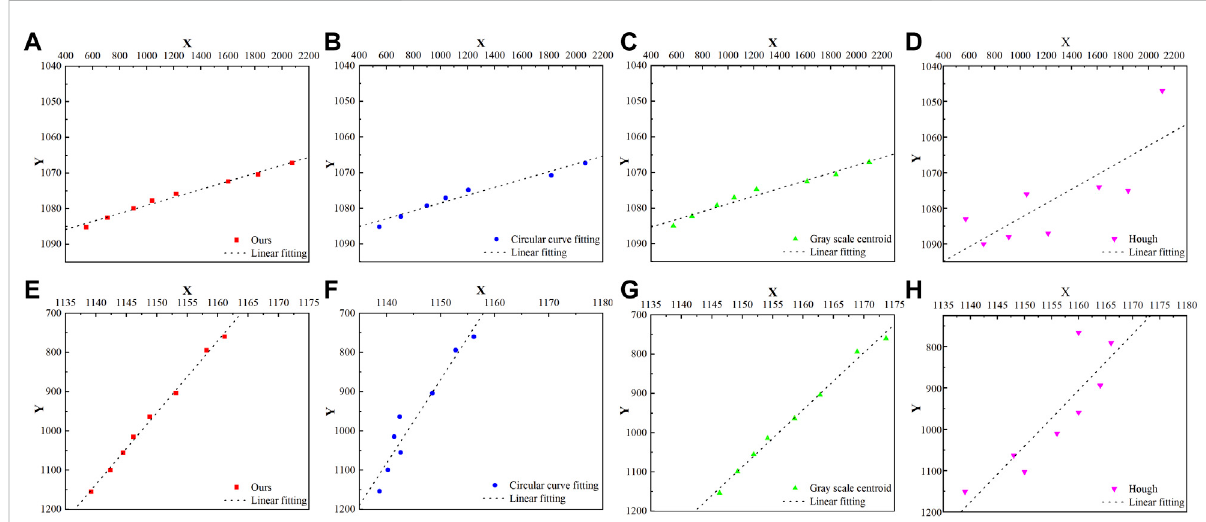
FIGURE 8 Results of fi tting straight lines with different methods. (A) : Results of our method in horizontal direction; (B) : Results of Circular curve fi tting method in horizontal direction; (C) : Results of Gray scale centroid method in horizontal direction; (D) : Results of Hough transform method in horizontal direction; (E) : Results of our method in vertical direction; (F) : Results of Circular curve fi tting method in vertical direction; (G) : Results of Gray scale centroid method in vertical direction; (H) : Results of Hough transform method in vertical direction;